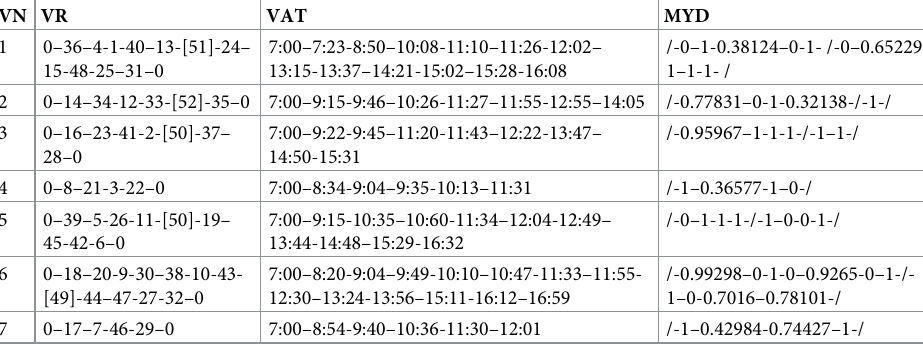
Table 9. H-NSGA-II optimal route distribution scheme. VN VR